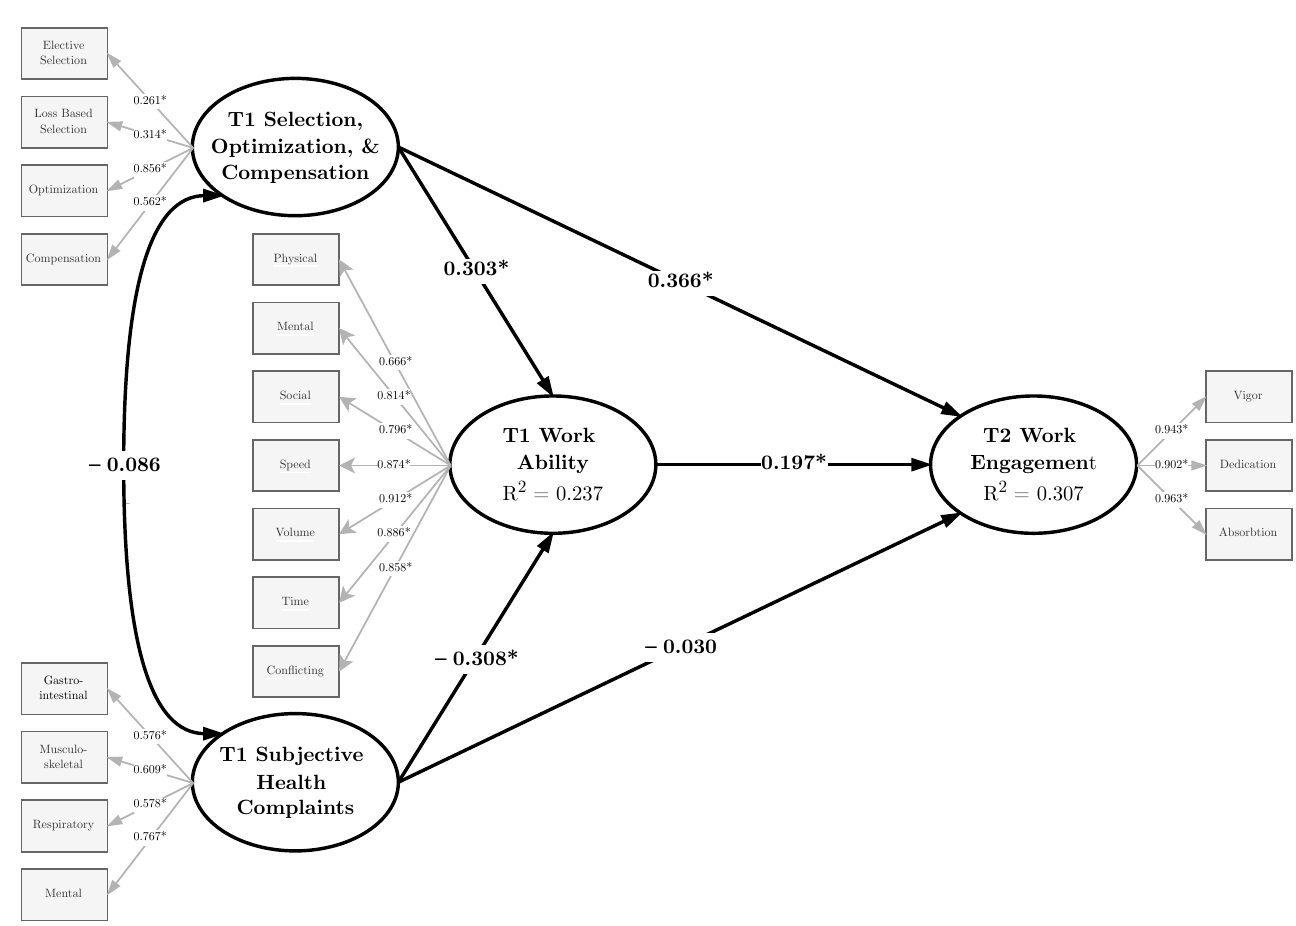
Figure 1. Summary of structural equation model (SEM). Model fit: χ 2 RMSEA = 0.052, SRMR = 0.039. Standardized factor loadings and path coefficients are reported here. For the sake of parsimony, covariates (i.e., age, sex, education, income, work hours, and job role) are omitted from this representation. * = p <